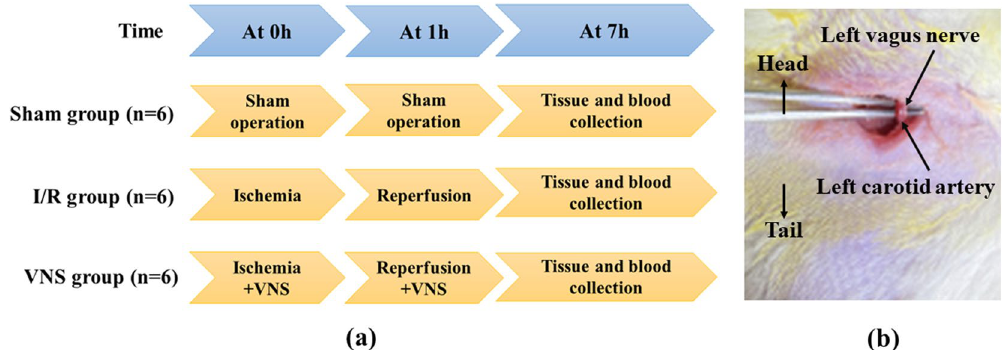
Figure 9. Experimental protocol ( a ) and location of the left vagus nerve ( b ). Sham sham operation, I/R ischemia–reperfusion, VNS vagus nerve